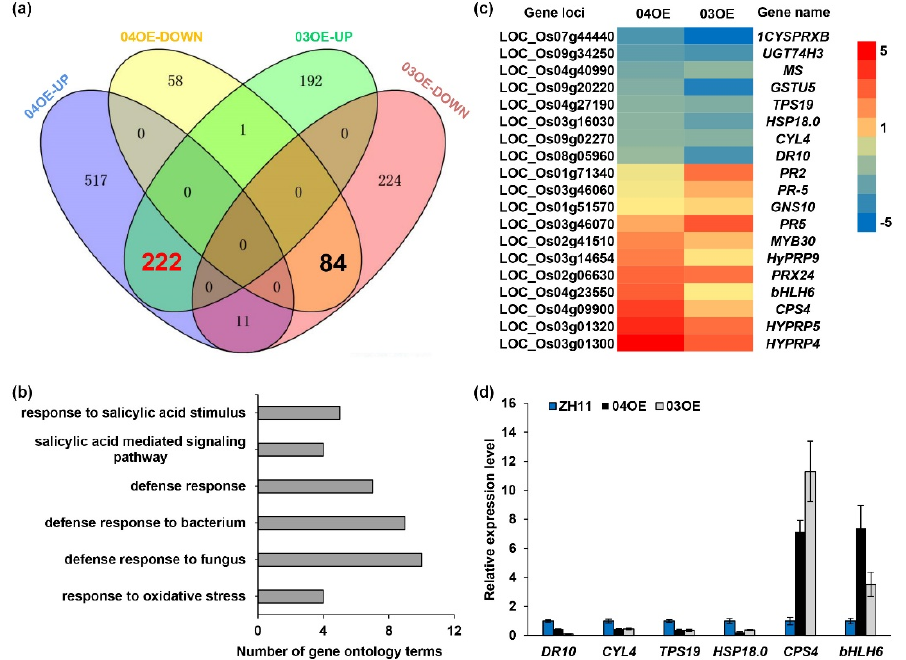
Figure 6. OsF3H 04g negatively regulates the rice defense response to Xoc. ( a ) Venn diagram of the upregulated and downregulated genes in OsF3H 04g (04OE-1) and OsF3H 03g (03OE-2) OE lines. ( b ) Gene ontology terms of defense response-related pathways for the common differentially expressed genes (DEGs). The 222 upregulated and 84 downregulated genes in the OsF3H 04g and OsF3H 03g OE lines were analyzed and enriched. ( c ) Heatmap of common DEGs related to defense response, SA response and signaling pathway. ( d ) qRT–PCR analysis of the expression of SA-related genes and defense response genes in OsF3H 04g and OsF3H 03g OE lines. OsACTIN was used as an internal con- trol. Data represent the means ± SD, n = 3. 3. Discussion In this work, we revealed that the TALE Tal2c acts as a virulence factor that shows a redundant function with previously reported Tal2b in most Xoc strains, including the highly virulent strain HGA4. The detailed interaction between the two TALEs and targets is illustrated in Figure 7, and these interactions are further described in the following main results. We identified that Tal2c binds to the EBE of the OsF3H 04g promoter to promote infection in rice. Overexpression of OsF3H 04g resulted in increased susceptibility, de- creased SA accumulation and shared common DEGs with the OsF3H 03g -OE line. The EBE editing lines of OsF3H 03g and OsF3H 04g specifically confer resistance to Tal2b- or Tal2c- containing strains. Overall, we significantly broadened the knowledge of TALE-mediated susceptibility to Xoc.